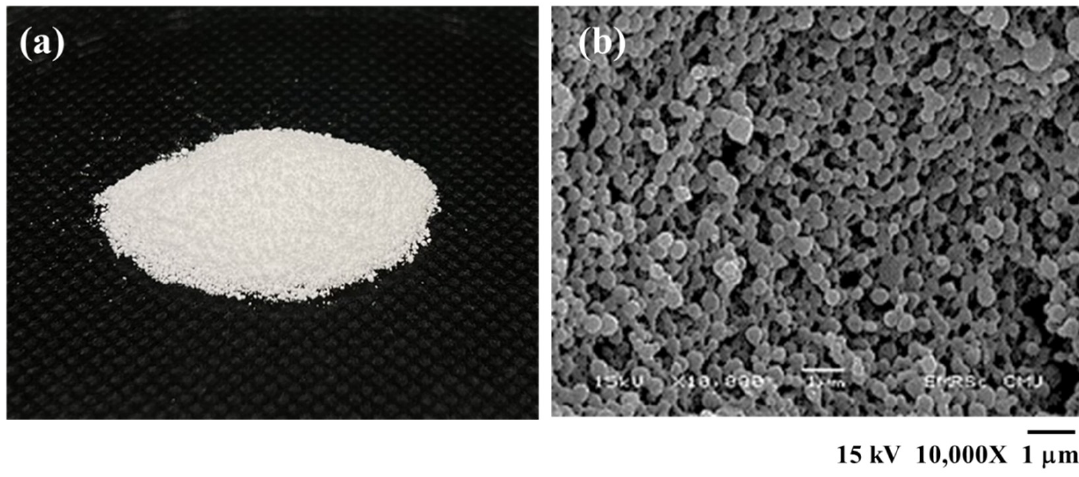
Figure 4. ( a ) Photograph and ( b ) SEM image of LL-37-encapsulated in PLG microparticles with 8% ( w / v ) of PLG, 0.25% ( w / v ) of PVA, and 4% ( w / v ) of